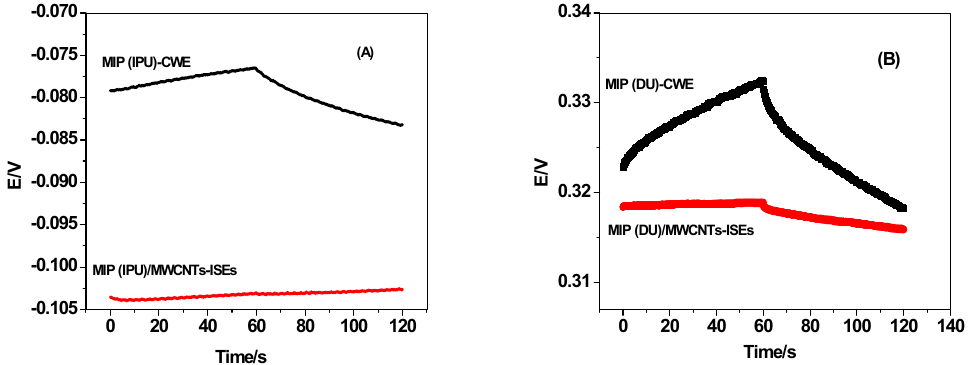
Figure 9. Chronopotentiometric plots of ( A ) MIP (IPU) / MWCNTs-ISEs (red) and MIP (IPU)-CWE (black) in the 10 − 4 M IPU solution. ( B ) MIP (DU) / MWCNTs-ISEs (red) and MIP (DU)-CWE (black) in the 10 − 4 M DU solution.